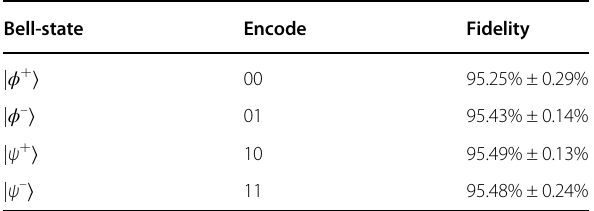
Table.1 Indication of the average fi delity with four Bell